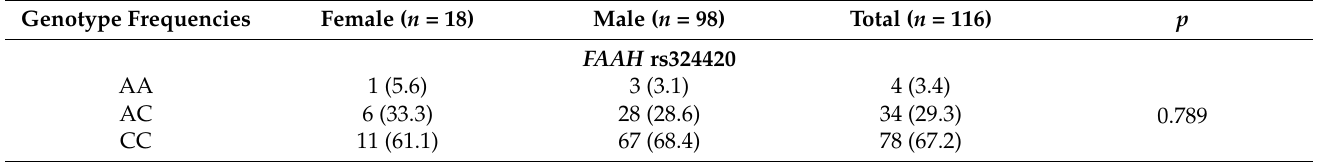
Table 3. Genotype frequencies of the selected genetic polymorphisms in elite rink-hockey players ( n = 116, 18 females and 98